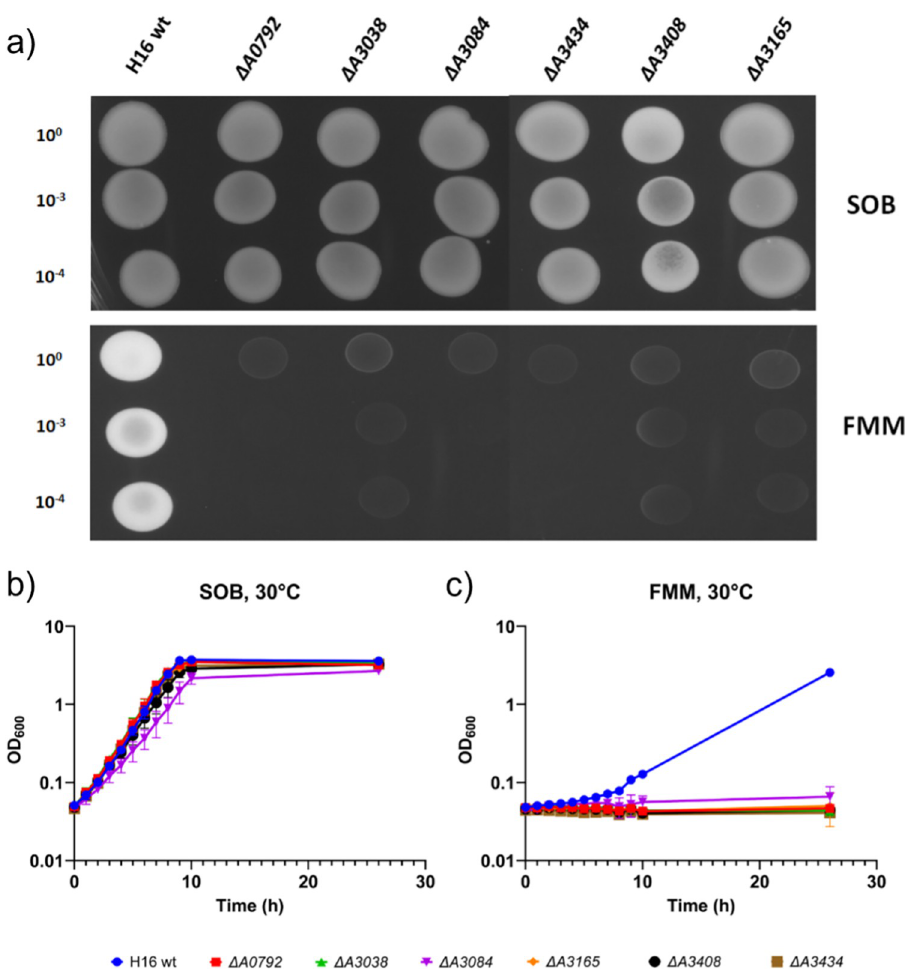
Fig 2. Growth of C . necator H16 wild type (H16 wt) and its isogenic mutants Δ A0792 , Δ A3038 , Δ A3084 , Δ A3165 , Δ A3408 and Δ A3434 on a) SOB (top panel) and FMM (bottom panel) plates, and liquid SOB (b) and FMM (c). Details about cultures set up are reported in the Methods